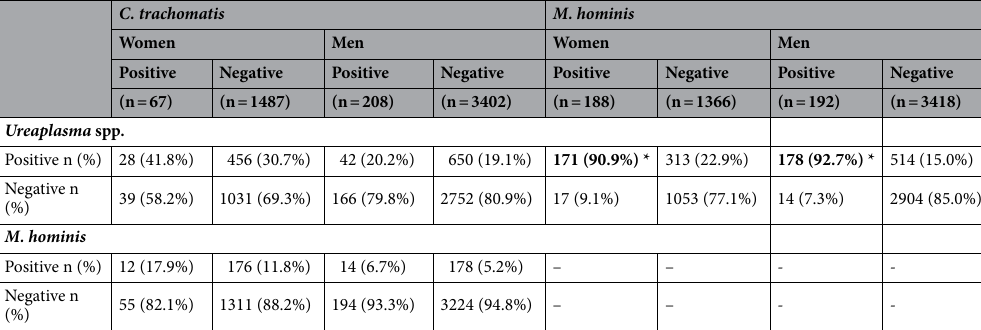
Table 3. C. trachomatis , Ureaplasma spp. and M. hominis co-infections in patients with couple’s primary infertility. Univariate analysis. 95%CI: 95% confident interval. A * p < 0.05 was considered statistically significant. Bold p numbers mean those which are statistically significant (<